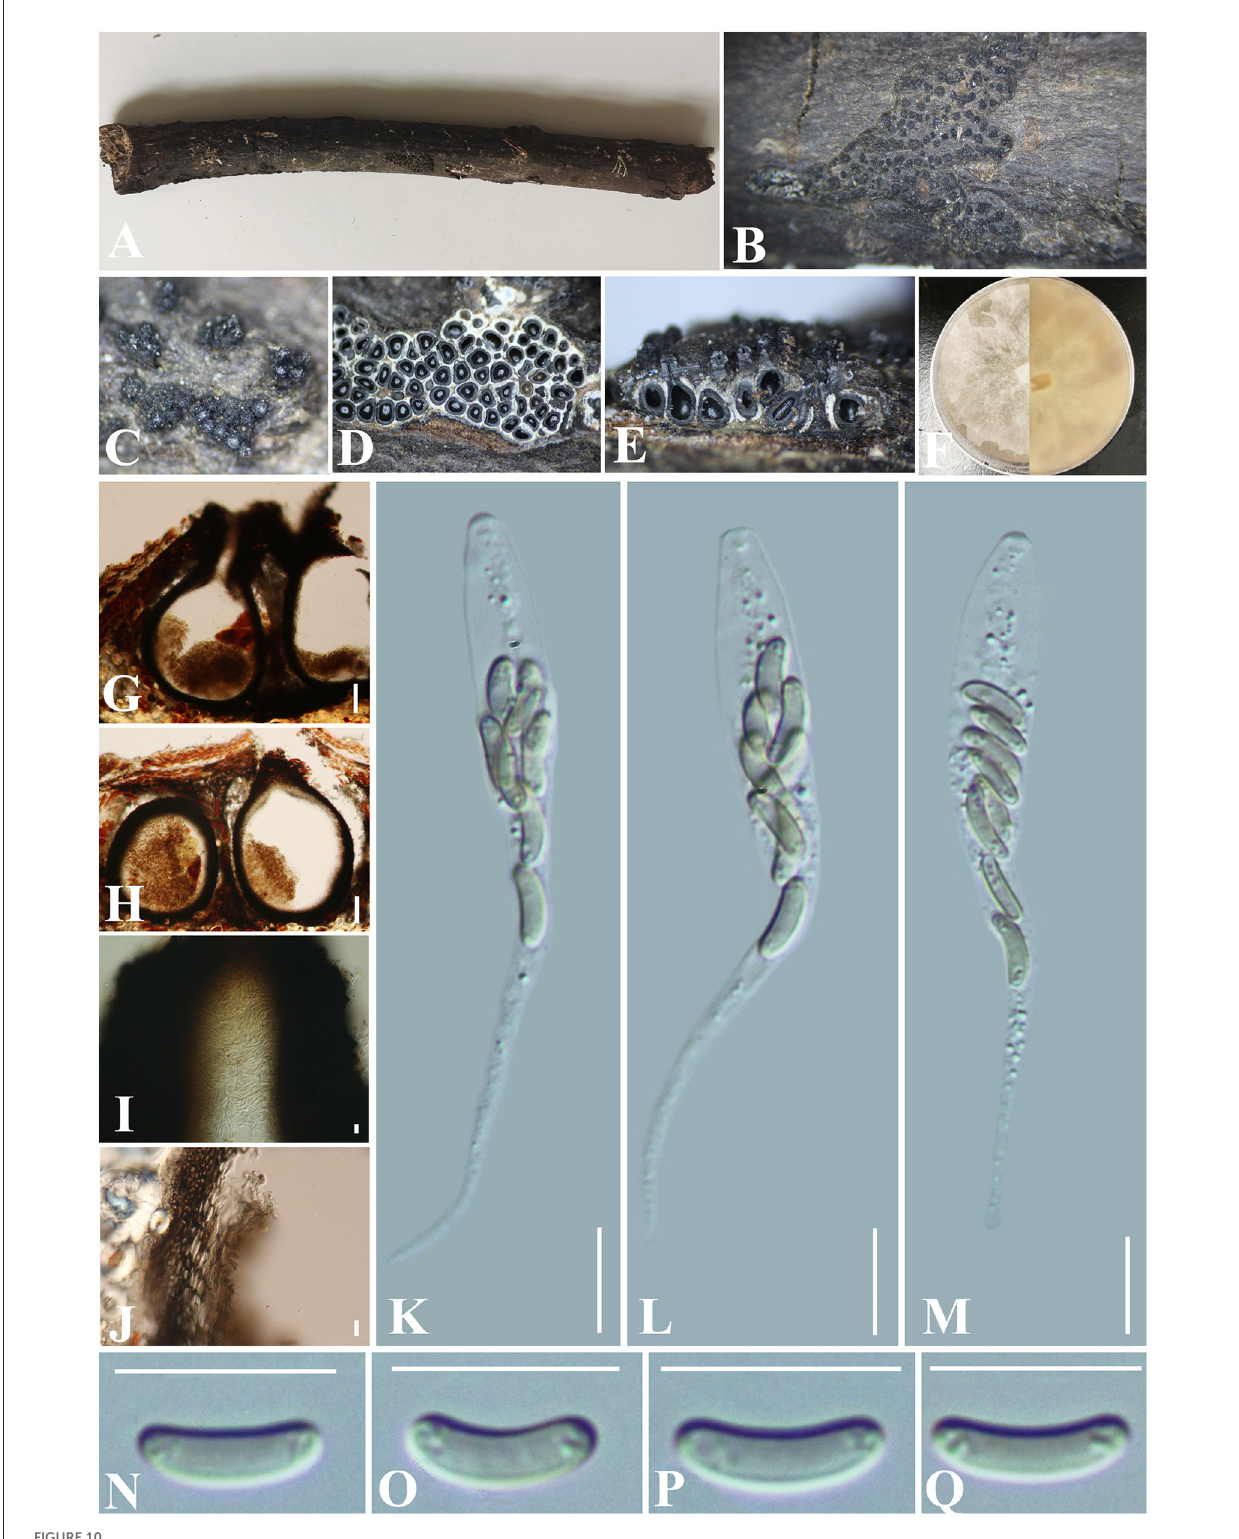
FIGURE10 Paraeutypella subguizhouensis (GMB0420, holotype). (A) Type material. (B, C) Close-up of stromata. (D) Transverse section trough stromata. (E) Vertical section through stromata. (F) Cultures on PDA. (G, H) Sections through the stromata. (I) Ostiolar canal. (J) Peridium. (K–M) Asci. (N–Q) Ascospores. Scale bars: (G, H) = 100 µ m; (I–Q) = 10 µ